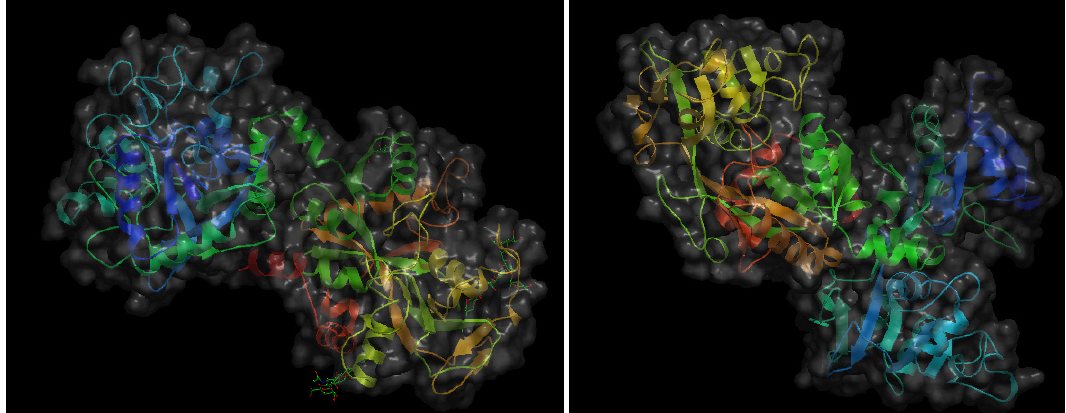
Figure 2. Schematic representation of the 3-D structures of bovine hololactoferrin at a resolution of 2.8 Å ( left ) and human apolactoferrin at a resolution of 2.0 Å ( right ). The files with pdb ID 1blf (bovine hololactoferrin) and 1cb6 (human apolactoferrin) were retrieved from protein data bank [16] and visualized with Open Astex Viewer maintaining proteins on a black background and representing protein surfaces in grey with a 30% of